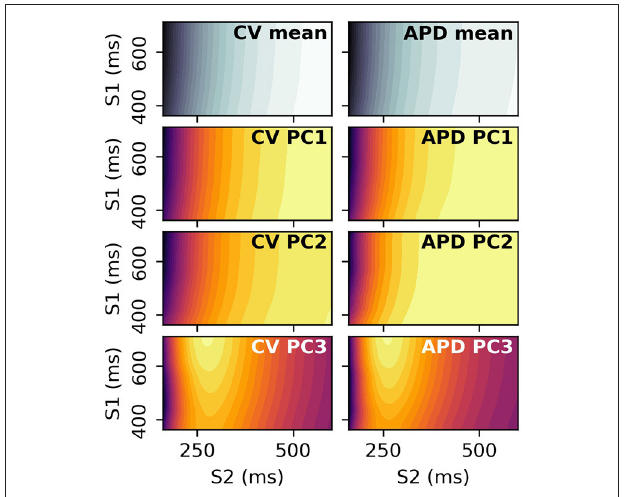
FIGURE 14 | Principal components and means of CV(S1,S2) and APD(S1,S2) restitution surfaces, displayed as contour plots where dark/light colors represent low/high values, respectively. These surfaces are 2D analogues to the curves in Figure 2